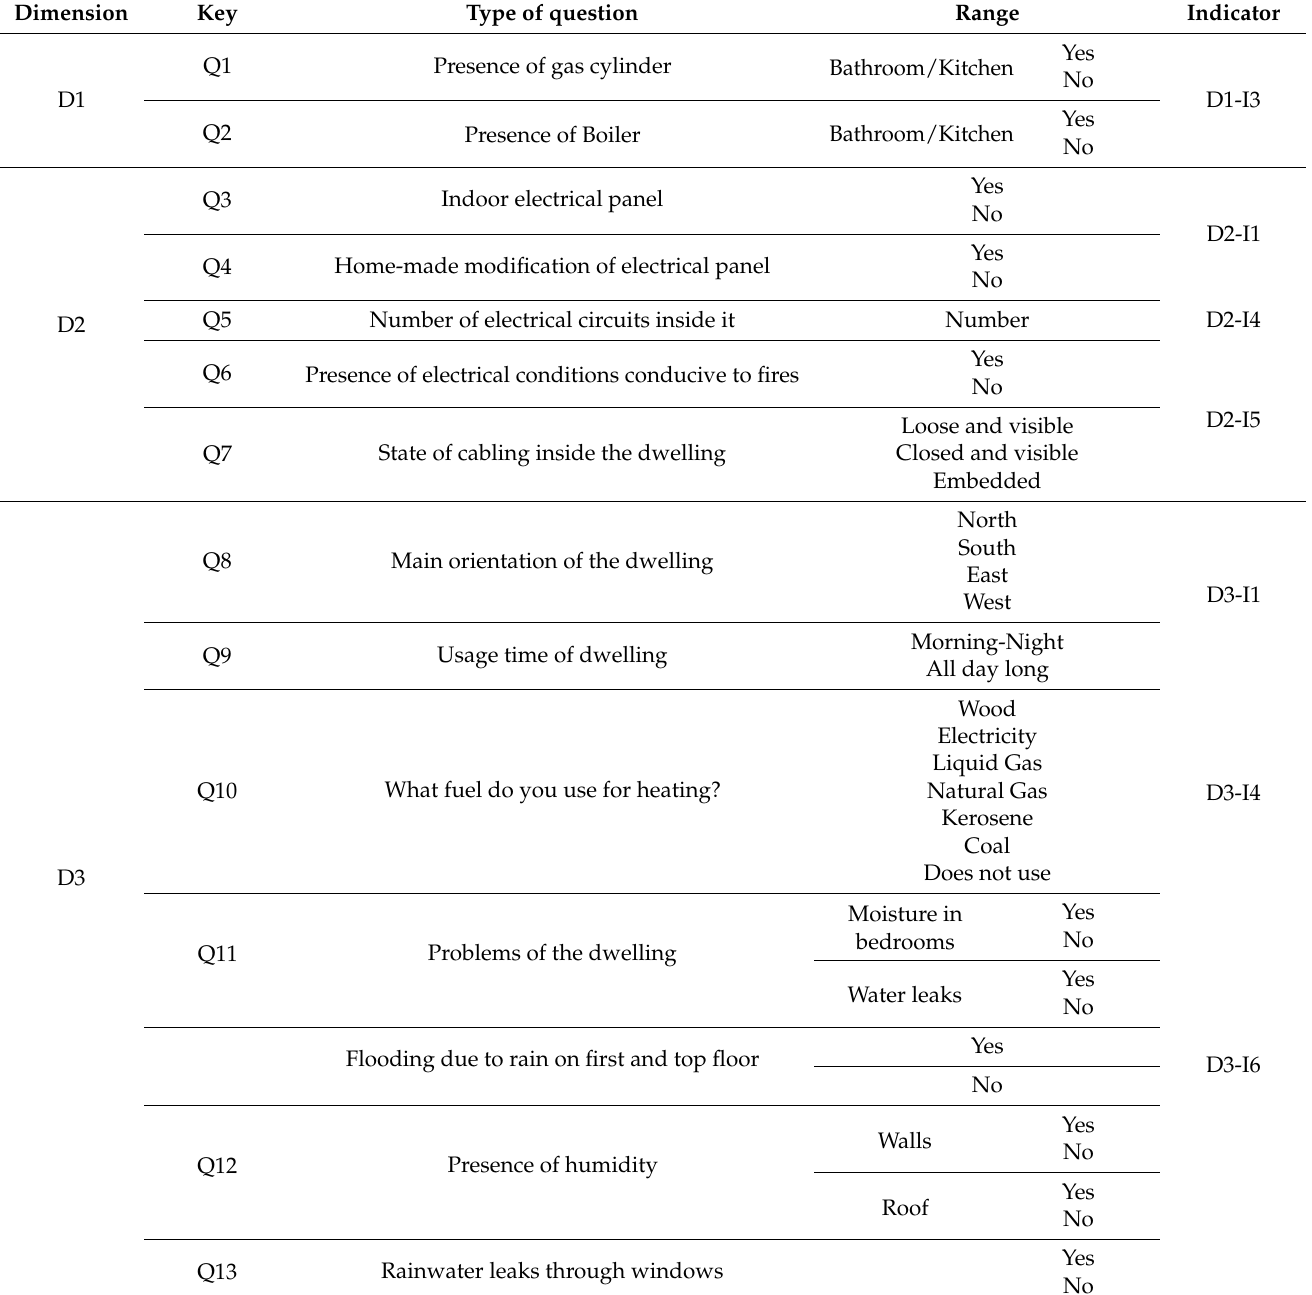
Table 2. Data collection, questions, answers, variables and data range (Authors’ own